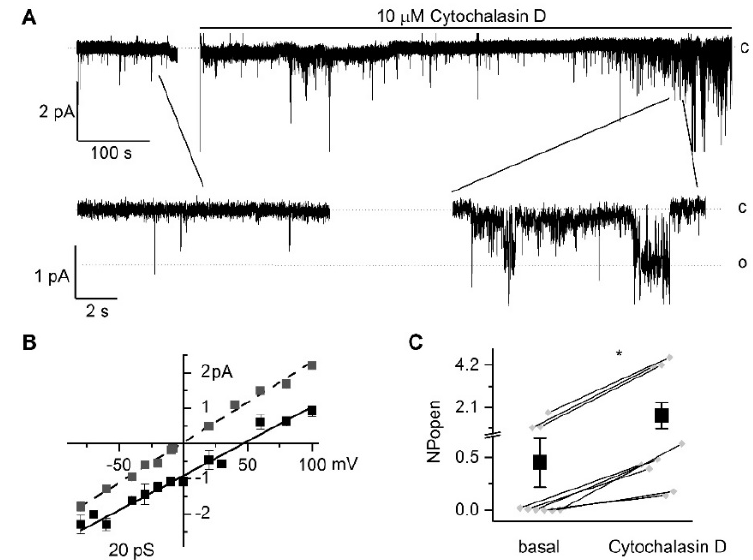
Figure 2. Effect of cytochalasin D on TRPC6 (Transient Receptor Potential Canonical 6) channels overexpressed in CHO (Chinese Hamster Ovary) cells. ( A ) Representative trace of TRPC6 channel activity before and after application of 10 µM cytochalasin D at a holding potential of –40 mV. Expanded fragments are shown below. Closed (c) and open (o) states are indicated. ( B ) Current-voltage relationship of overexpressed TRPC6 with estimated conductance 20 ± 1 pS in cell-attached mode (black squares) and subsequent excision to inside-out mode (grey squares). ( C ) Summary graph demonstrating the effect of the application of 10 µM cytochalasin D on TRPC6 channel activity (NP o ). Wilcoxon nonparametric test for paired samples; * = p < 0.05.